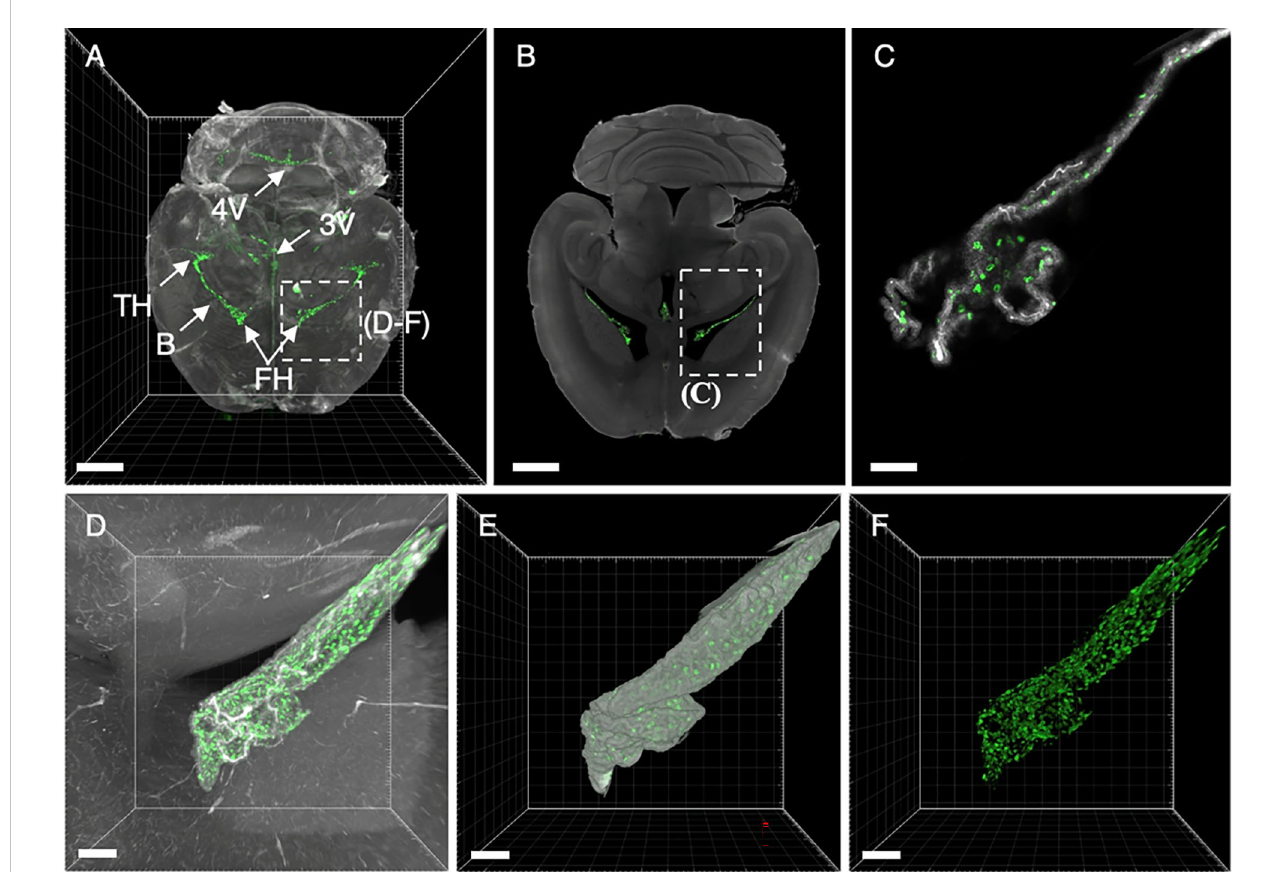
FIGURE 7 3D renderings and single digital sections reveal EpCAM binding to choroid plexi in the brain. (A) Dorsal MIP of the entire brain anatomy derived from the auto fl uorescence (grey) and binding of the EpCAM-speci fi c antibody G8.8R (green). (B) Single LSFM image reveals anti-EpCAM antibody binding to choroid plexi of the temporal horn (TH), frontal horn (FH), 3rd ventricle (3V), 4th ventricle (4V, in A) and body (B, central part). (C) Higher magni fi cation image of area indicated in image B displays binding to individual choroid plexus cells. (D) Maximum intensity projections (MIP) and (E, F) surface renderings of the entire frontal horn choroid plexus with bound anti-EpCAM antibody (G8.8R) extending into the ventricular space as indicated in image (A) . Scale bars = 2 mm (A, B) and 100 m m (C – F)